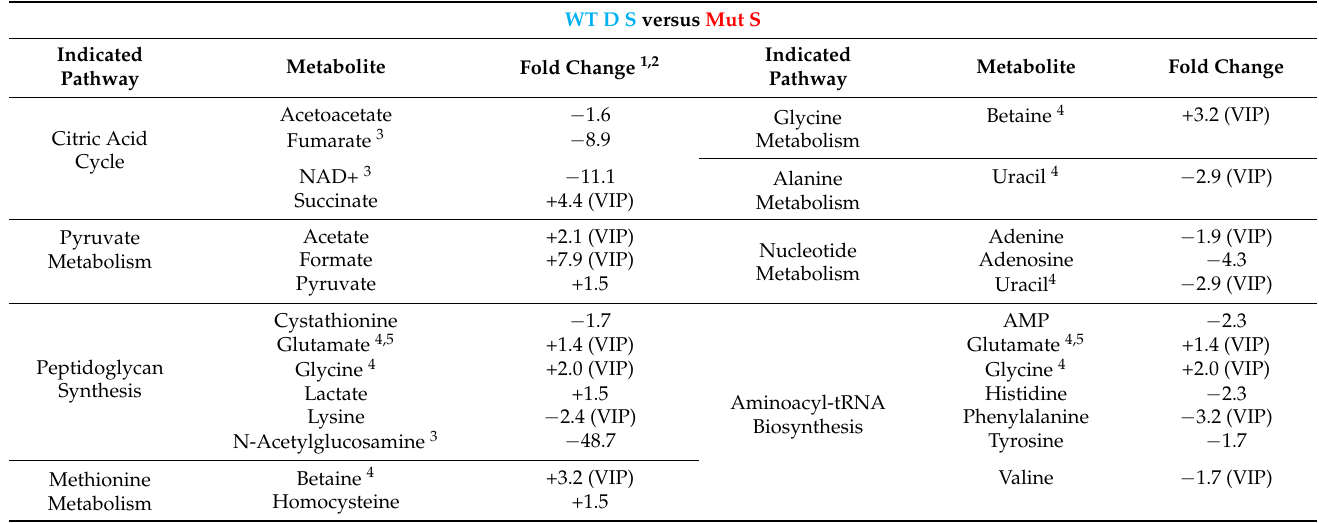
Table 11. Fold change of statistically significant metabolites in their corresponding metabolic pathways for the stationary phase of DABCOMD challenged wild type versus unchallenged